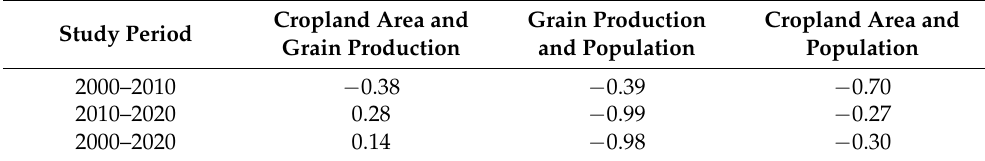
Table 4. Consistency of spatial changes in the